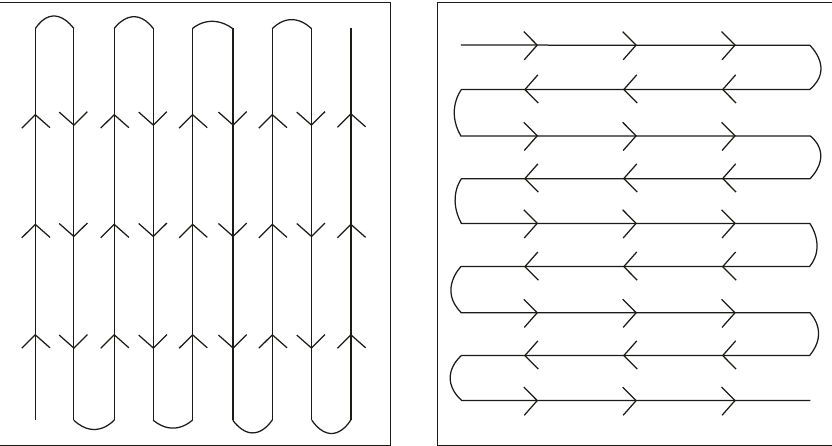
Figure 2: Schematic diagram of the electrode movement.